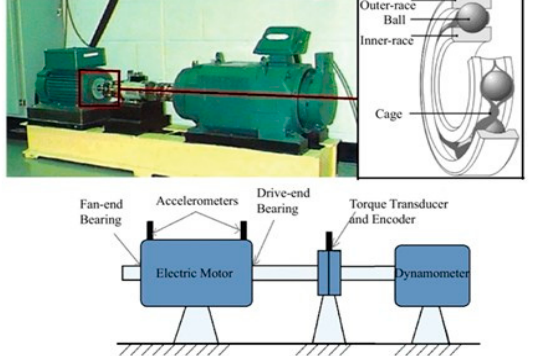
Figure 8. Bearing elements and an experimental setup of the CWRU bearing test rig for a ball bearing system